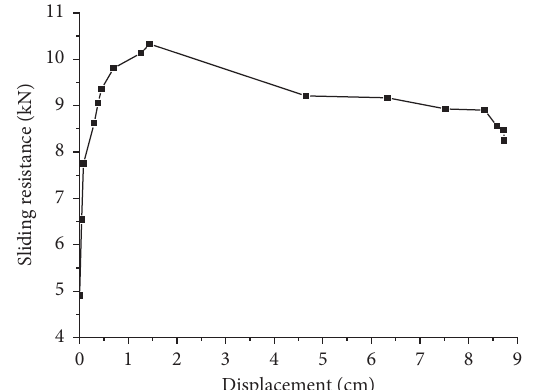
Figure 10: Relationship between fastener sliding resistance and pad displacement.